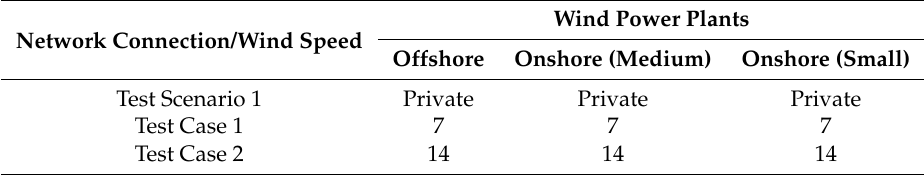
Table 5. Test Scenario 1—with all Private Network Connections—Ideal Case.